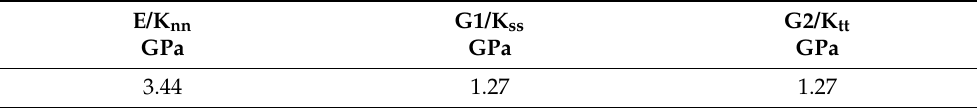
Table 6. Directional stiffness properties of adhesive.